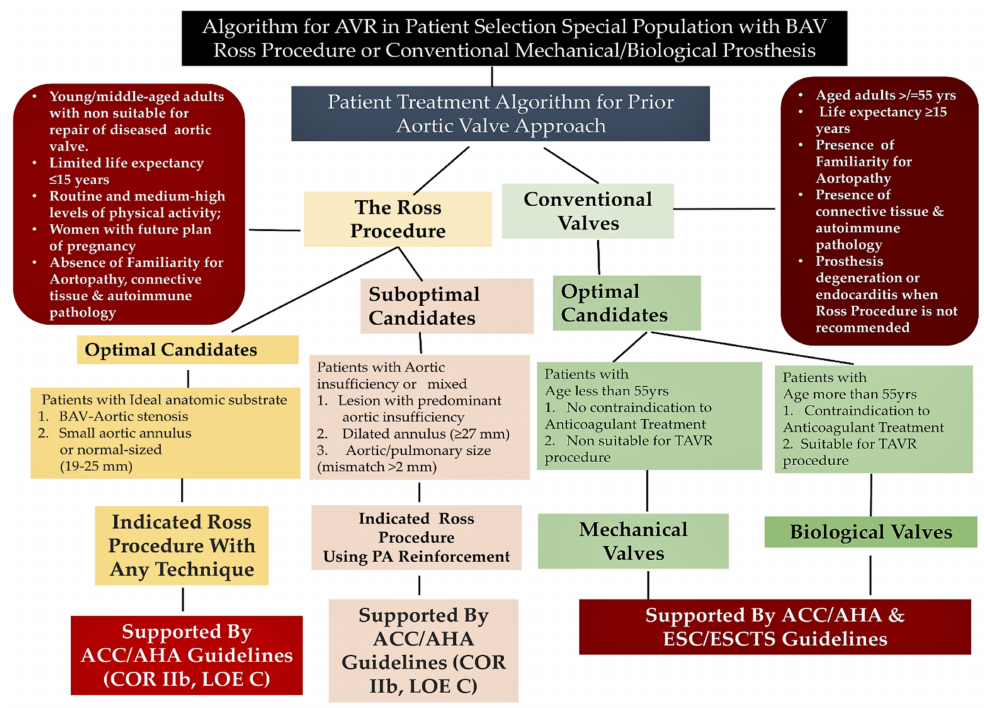
Figure 13. Algorithm for patient special population selection for aortic valve replacement.